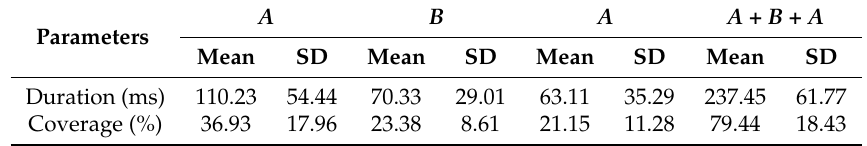
Table 2. The duration and coverage of microstate mode (Mean and SD) in 11 subjects and 12 visual stimuli.